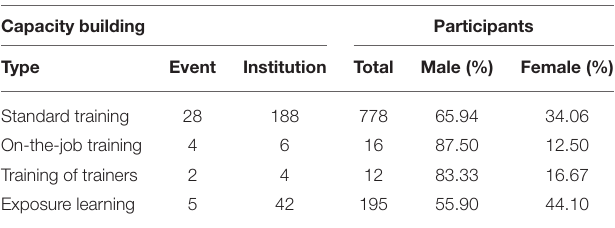
TABLE 5 | Different types of capacity building activities during October 2015–September 2018.